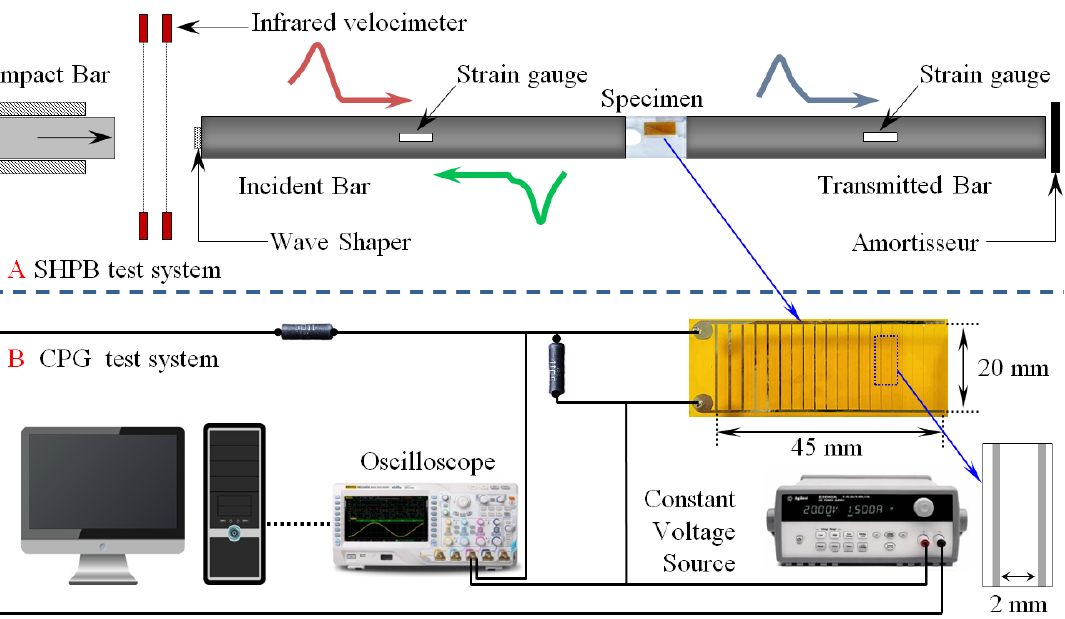
Figure 3. Split-Hopkinson pressure bar (SHPB) system and Crack Propagation Gauge (CPG) system.